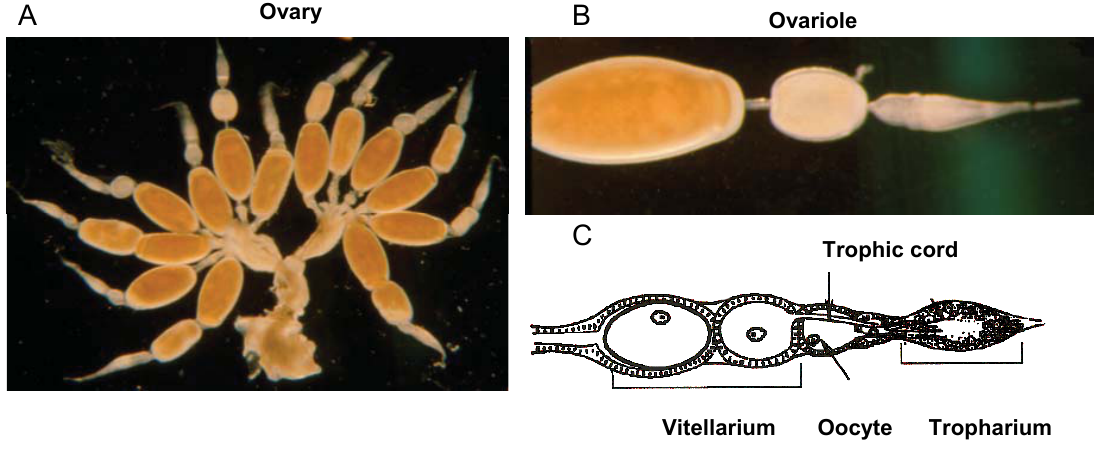
Fig. 1 – The ovary of Rhodnius prolixus : The ovary was dissected at day 5 after blood meal and spread onto a glass slide and photographed. The ovary (A) is composed of two hemi-ovaries that are connected by a common oviduct. Each hemi-ovary is composed of seven structures named ovariole. From the hemi-ovary depicted at the right side of Fig. 1A one ovariole was removed to be shown in detail (B). A line drawing of the ovariole is shown in (C), in order to represent the internal structures (After Huebner and Anderson